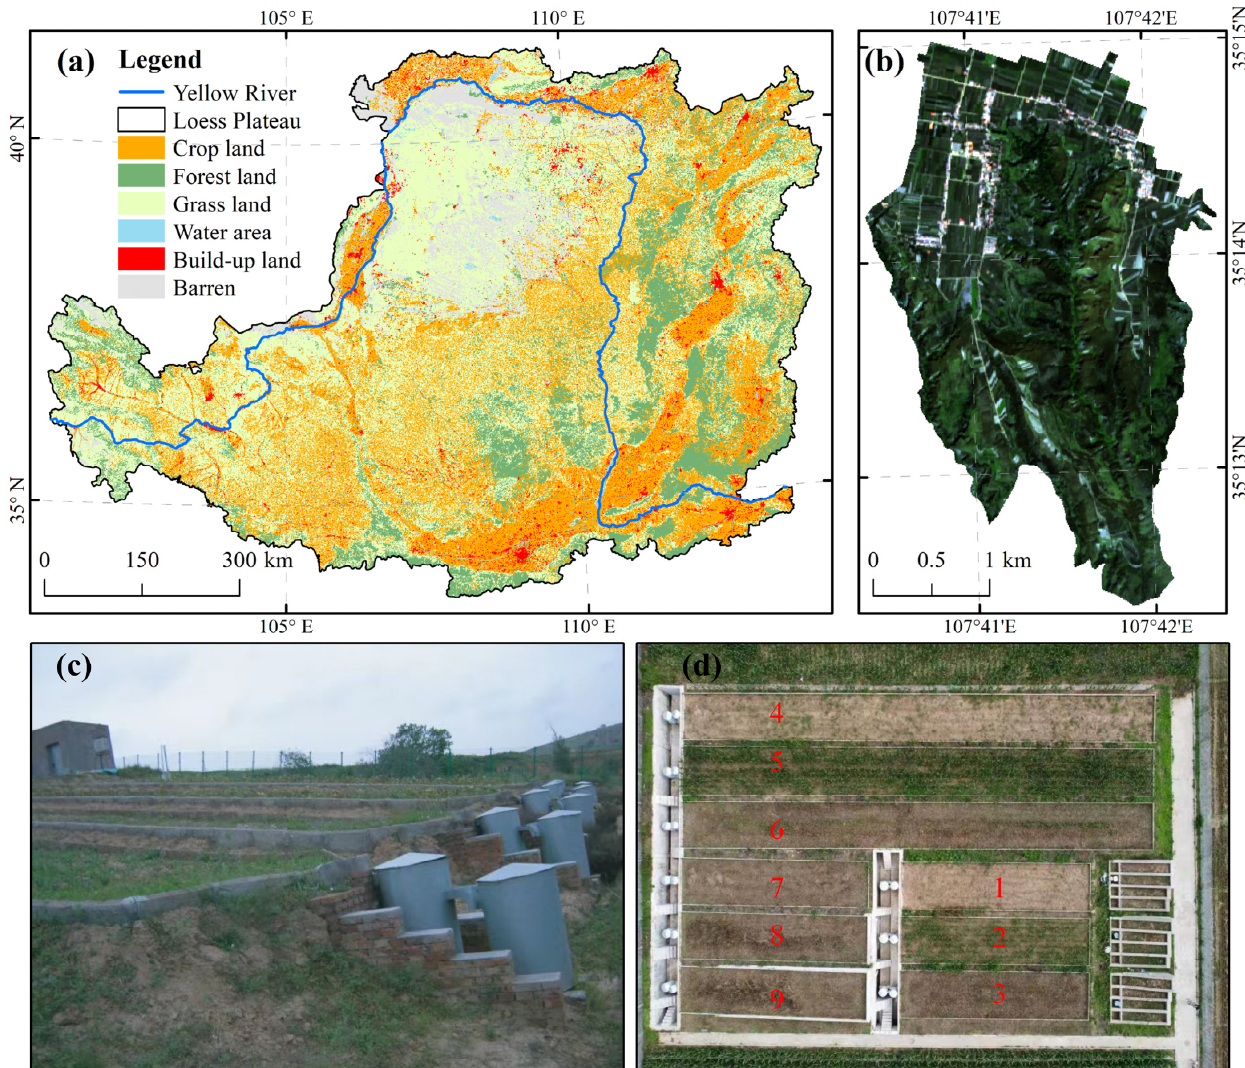
Figure 1. Location of the study site and experimental design. ( a ) the Loess Plateau of China, ( b ) Wangdonggou watershed on the Loess Plateau of China, ( c ) runoff and sediment collecting equipment, and ( d ) nine runoff plots. Numbers of 1–9 show the locations of all nine runoff